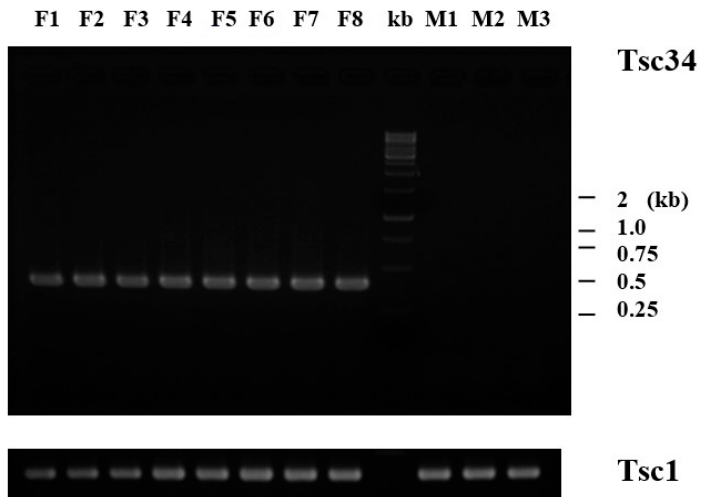
Figure 4. Female-specific expression of Tsc34, which encodes vitelline envelope zona pellucida domain 4. Total RNAs were isolated from gonads of fully grown abalones that exhibited eight female (F1–F8) and three male (M1–M3) gonads. RT-PCR was carried out using cDNA templates and primers specific for ribosomal protein L3 (Tsc1), and vitelline envelope zona pellucida domain 4 (Tsc34). Sizes of molecular weight (kb) markers are indicated.